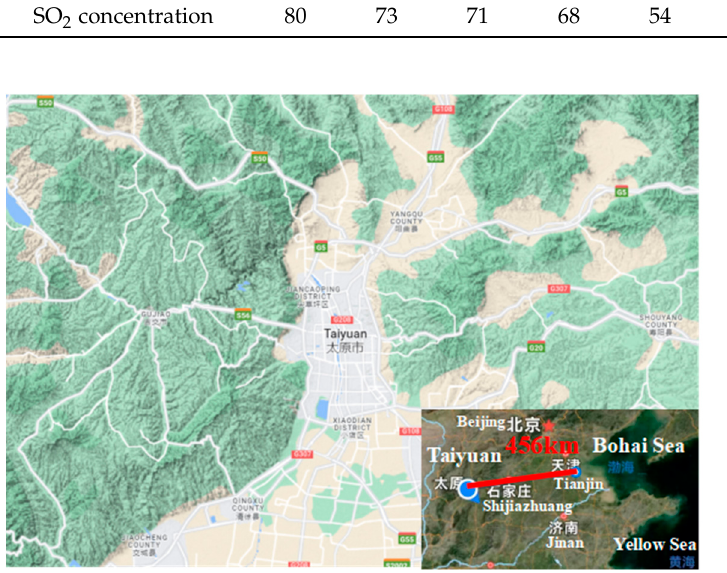
Figure 1. The location of Taiyuan. Table 2. Environmental characteristics of Taiyuan (2013–2020).